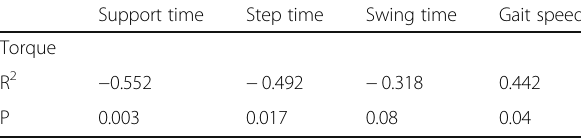
Table 3 Correlation between knee extensor torque and